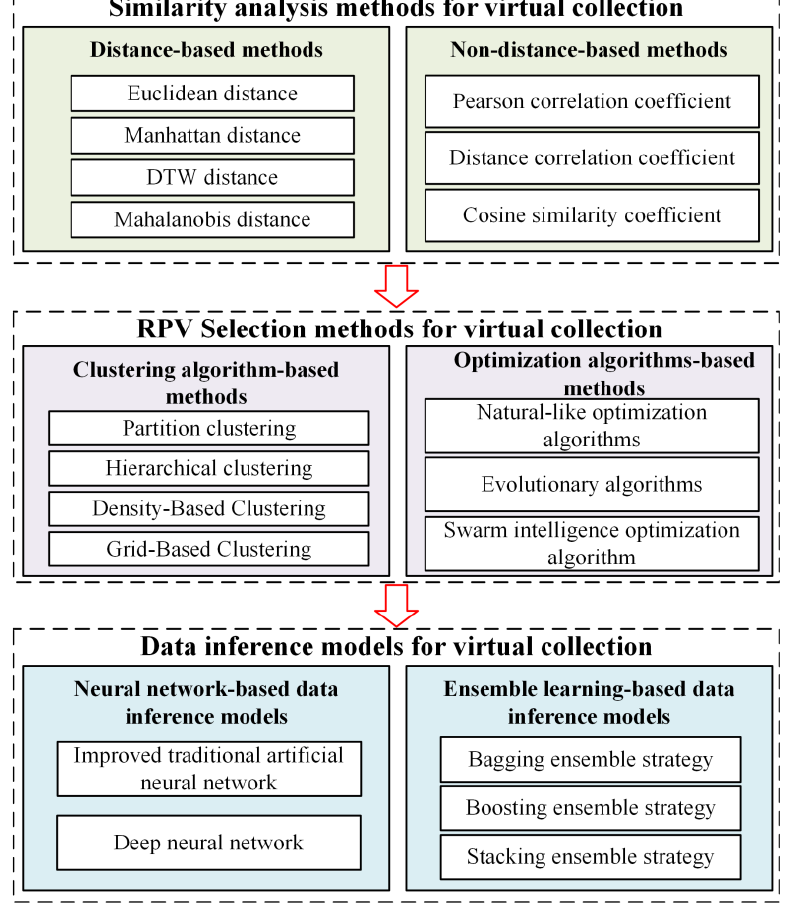
Figure 8. Summary of methods for virtual collection.